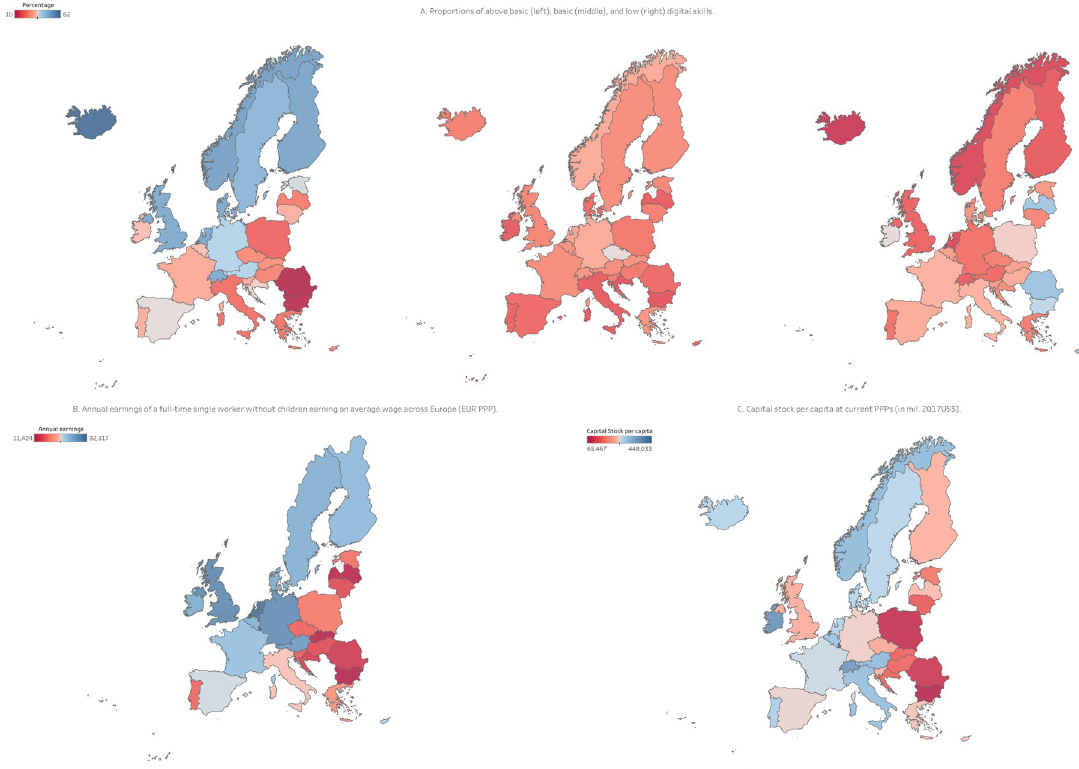
Fig 3. A geographical heat map of the distribution of digital skills (Fig 3A; left shows above basic skills, centre shows basic digital skills, and right shows low digital skills), annual net earnings (Fig 3B) [31], and capital stock per capita (Fig 3C) [32]. The maps were generated in Tableau using OpenStreetMap data (OpenStreetMap